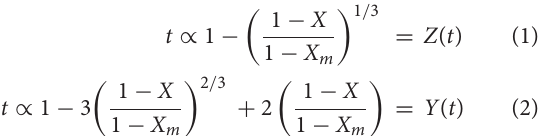
quality of gold and copper confirmed that the bioleaching